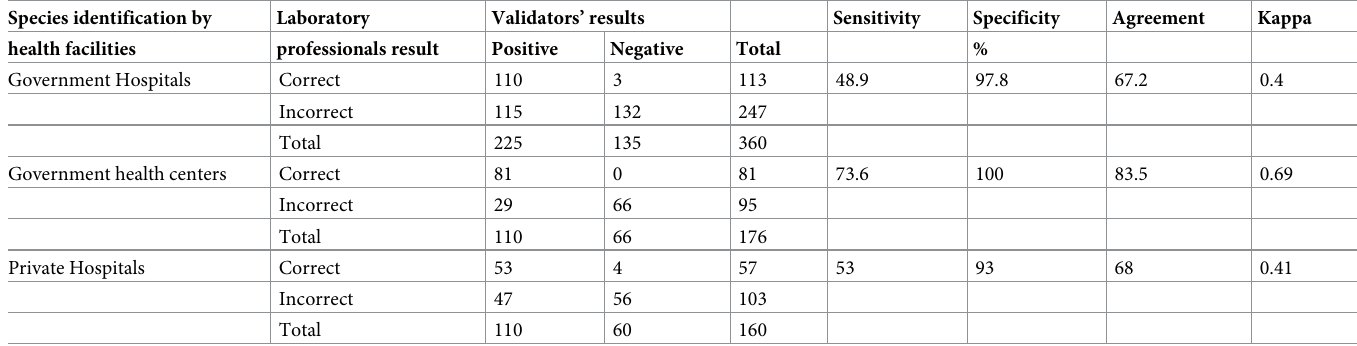
Table 4. Performance of laboratory professionals on the identification of Plasmodium species at private and government health facilities in Bahir Dar city adminis- tration from January to March 2017. Species identification